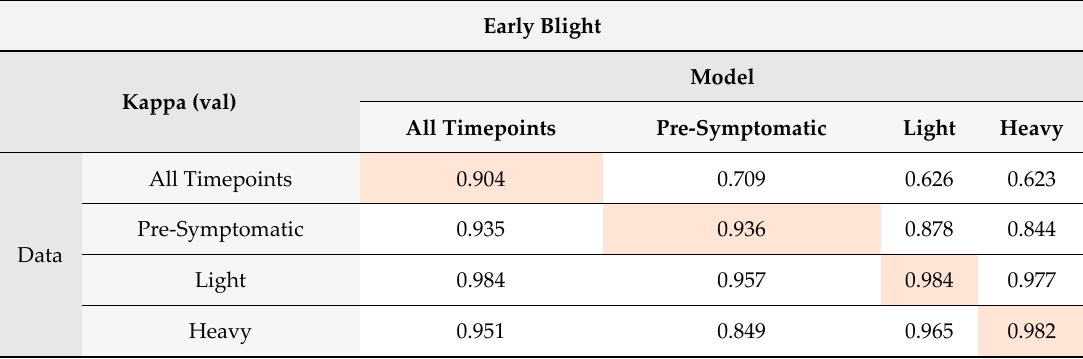
Table 2. Validation (kappa) for models classifying potato early blight disease at multiple disease stages across 100 permutations with a 70/30 calibration validation split. Models that were fit within a pathogen life stage perform well outside of the specific stage of development.